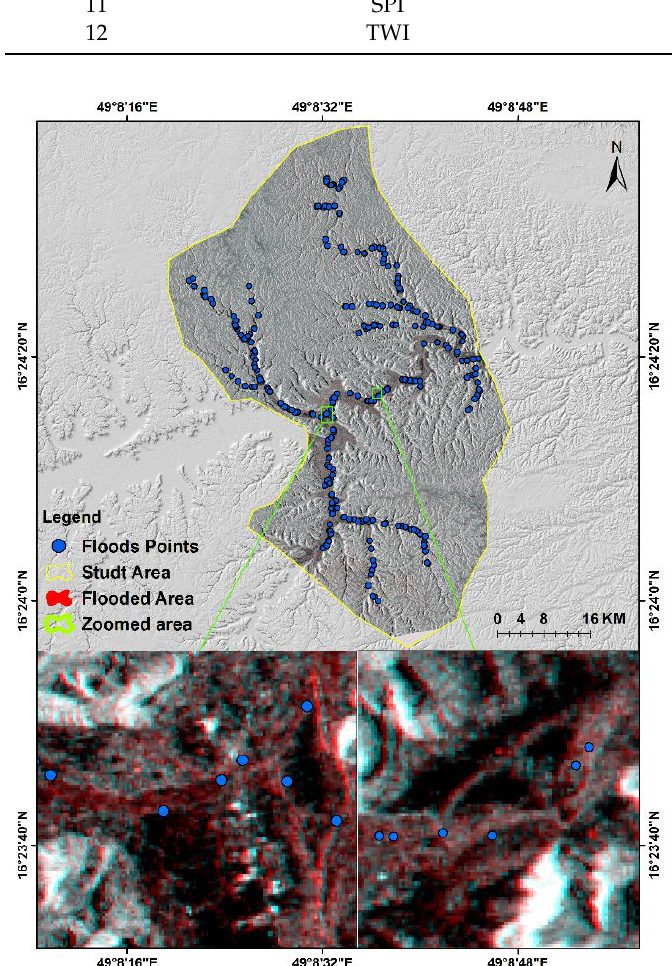
Figure 8. Flood detection using Sentinel-1 data in Tarim city.